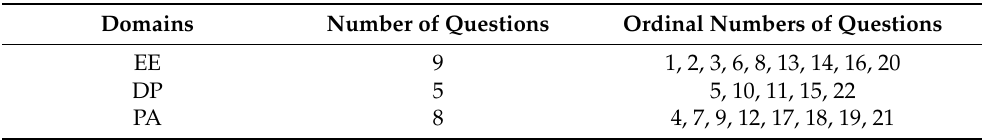
Table 1. Domains of the MBI-HSS-MP: emotional exhaustion (EE), depersonalization (DP) and personal accomplishment